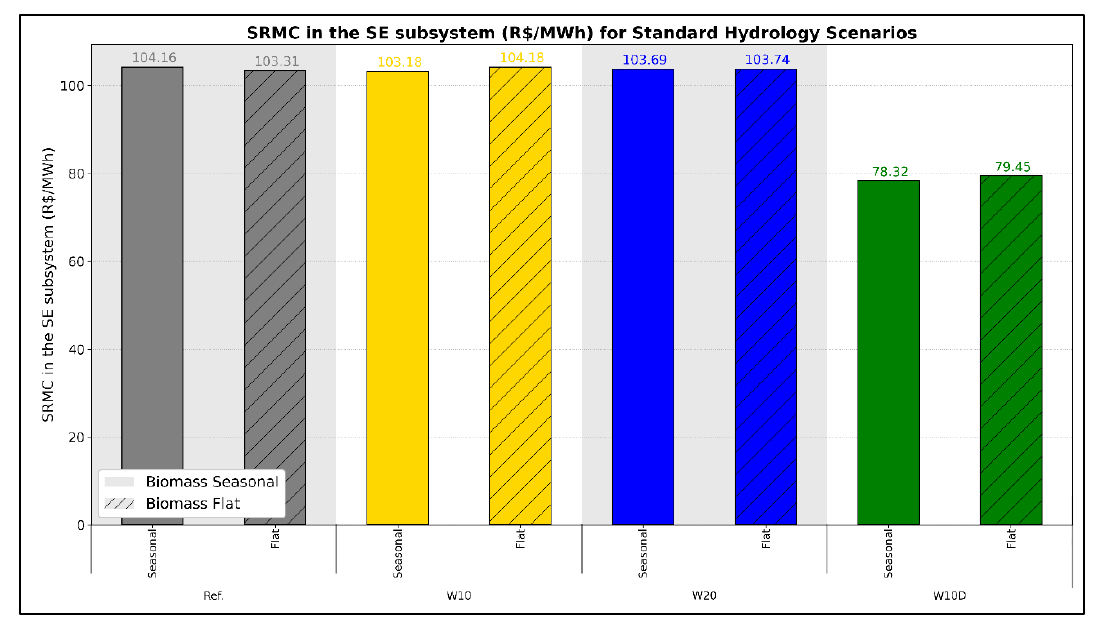
Figure 5. Short-run marginal cost for scenarios with standard hydrology.